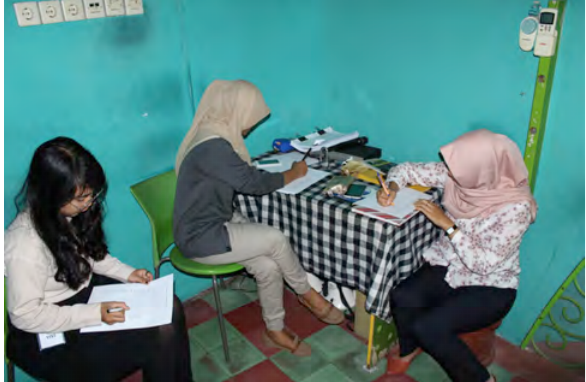
Figure 5: Museum's staff filling out the questionnaire - subjective indoor comfort assessment. (U. Pont 2016)